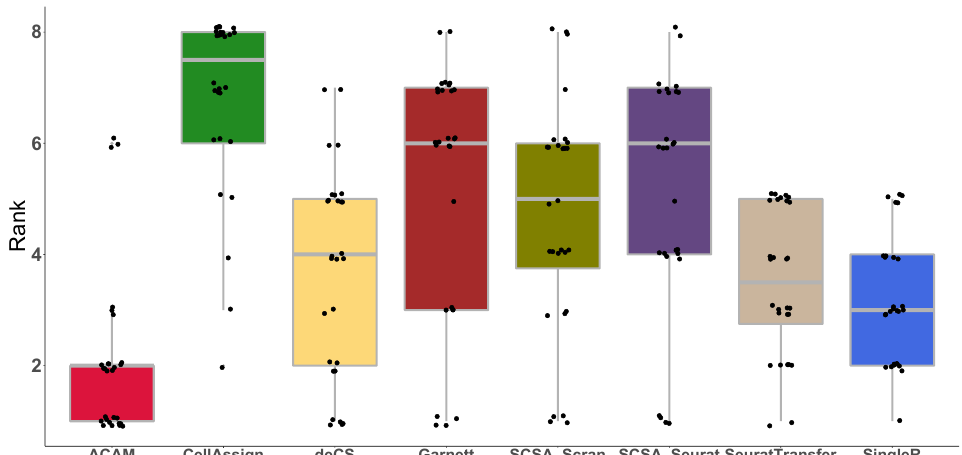
Figure 3. Rank of the compared methods. Boxplot of the rank of each method according to four evaluation metrics: accuracy, balanced accuracy, macro F1-score, and MCC on seven datasets is shown. A lower rank represents better performance (one is the best and eight is the